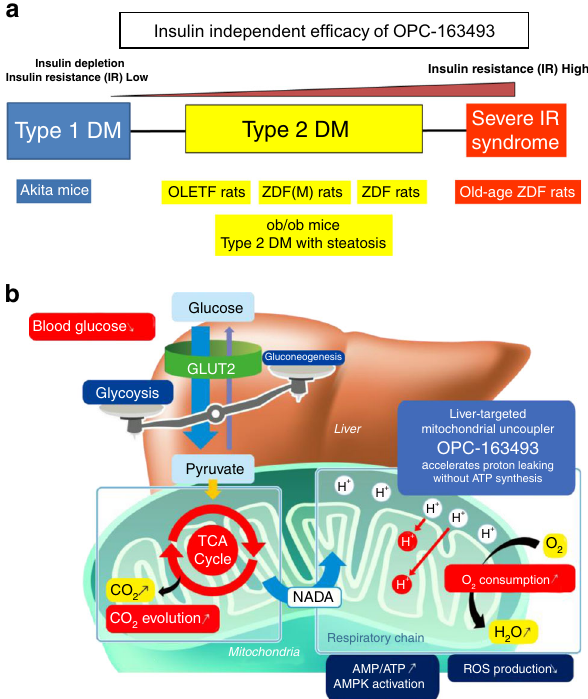
Fig. 10 Pharmacological ef fi cacy and MOA of